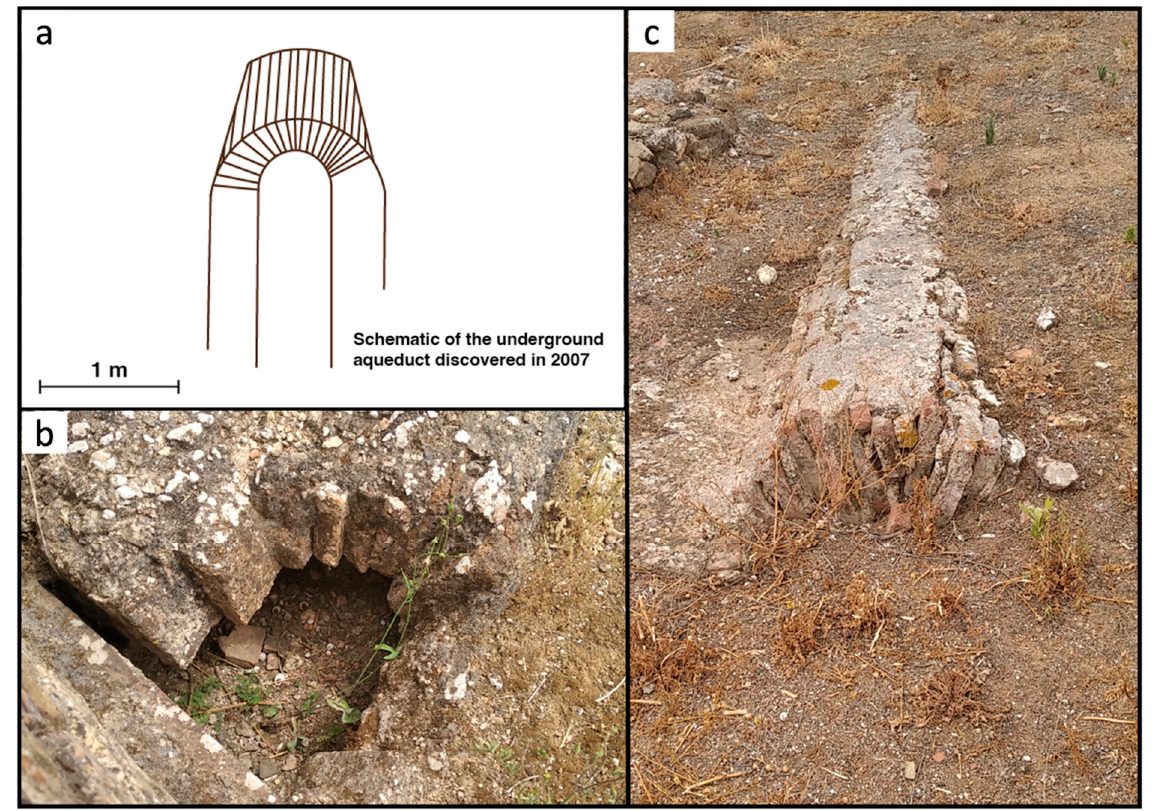
Figure 5. ( a ) Underground aqueduct schematics discovered in 2007 in an archaeological survey carried out on the outside of Pisões. ( b ) Upper part of duct 11. ( c ) Traces of the upper part of duct 39.